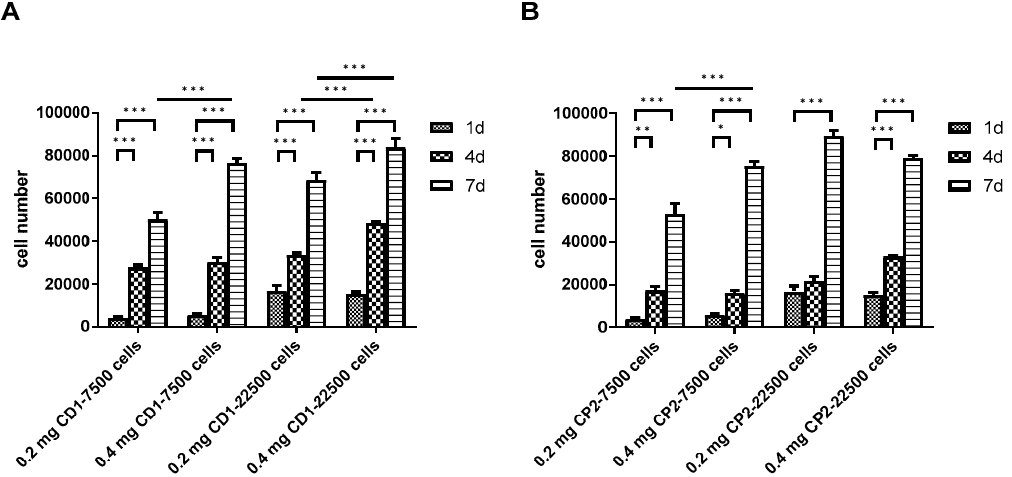
Figure 8. Changes in the number of viable DPSCs cultivated with ( A ) Cytodex 1 (CD1) or ( B ) Cytopore 2 (CP2) in 96- well non-attaching plates under static conditions for 7 days. Initially 7,500 and 22,500 cells were seeded into the wells containing 0.2 or 0.4 mg/ml microcarrier. Values are means +/- SEM (n=5). *p < 0.05, **p<0.005, ***p<0.001 in